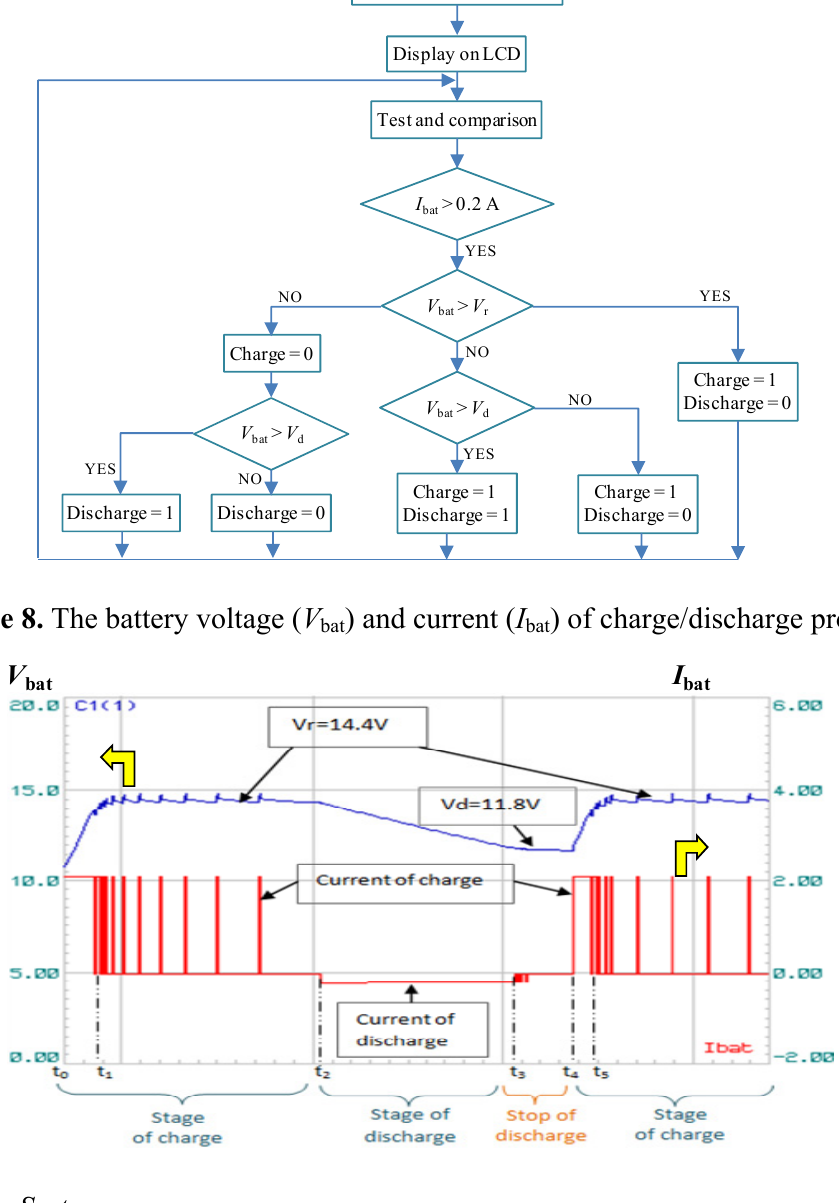
Figure 7. Control algorithm of process charge/discharge.